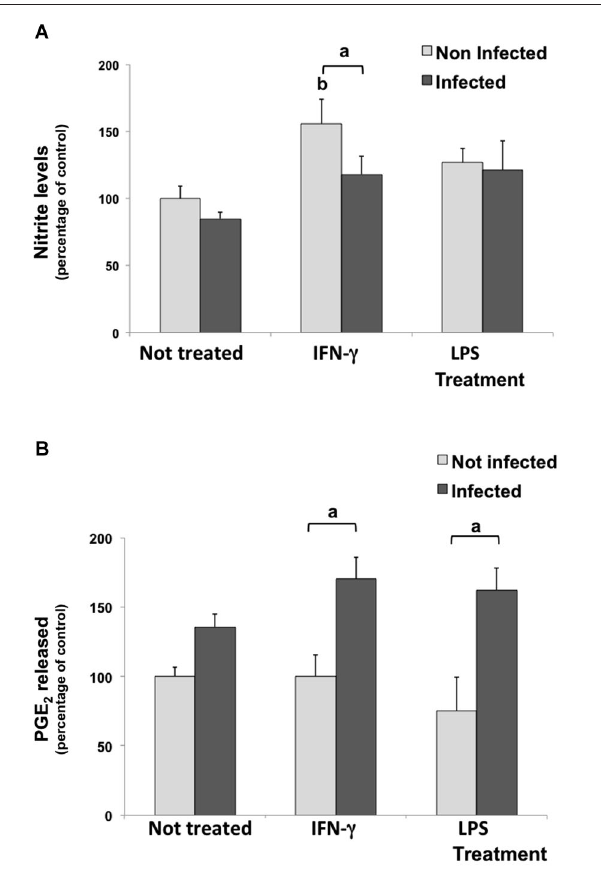
FIGURE 3 | Nitrite (A) and Prostaglandin E2 (PGE 2 ) (B) levels in culture media of rat neuron/glial cell co-cultures treated with 300 IU/mL of IFN- γ and 1 mg/mL of LPS and infected with Neospora caninum tachyzoites (ratio cell:parasite 1:1), 72 h post infection . Results are expressed as the means ( ± SD) of the percentage of nitrite (A) or PGE 2 (B) compared to control conditions (considered as 100%) in three independent experiments carried out in triplicate. “a” represents a significant statistical difference between the same treatment group; “b” represents a significant statistical difference when compared to untreated/uninfected control cultures (Two-way ANOVA/Tukey’s Multiple Comparison Test— p < 0.05).